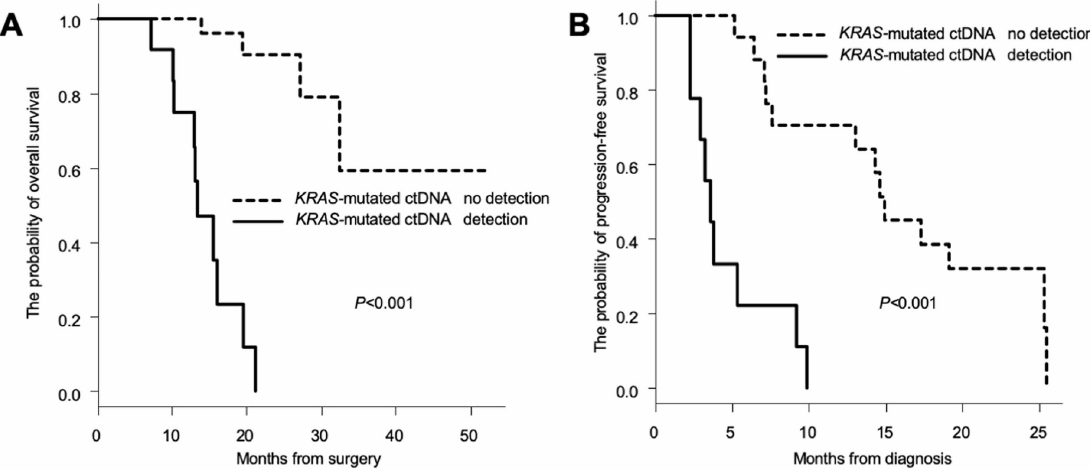
Fig 4. Sequential assessments of KRAS -mutated ctDNA within a short period to assess outcome. (A) Overall survival (OS) curves according to the emergence of KRAS- mutated ctDNA within 1 year after surgery ( P < 0.001 by log-rank test). (B) Progression-free survival (PFS) curves according to the emergence of KRAS- mutated ctDNA within 6 months of chemotherapy ( P < 0.001 by log-rank test). X-axes indicate the months from surgery and diagnosis, whereas Y-axes indicate the probability of OS and